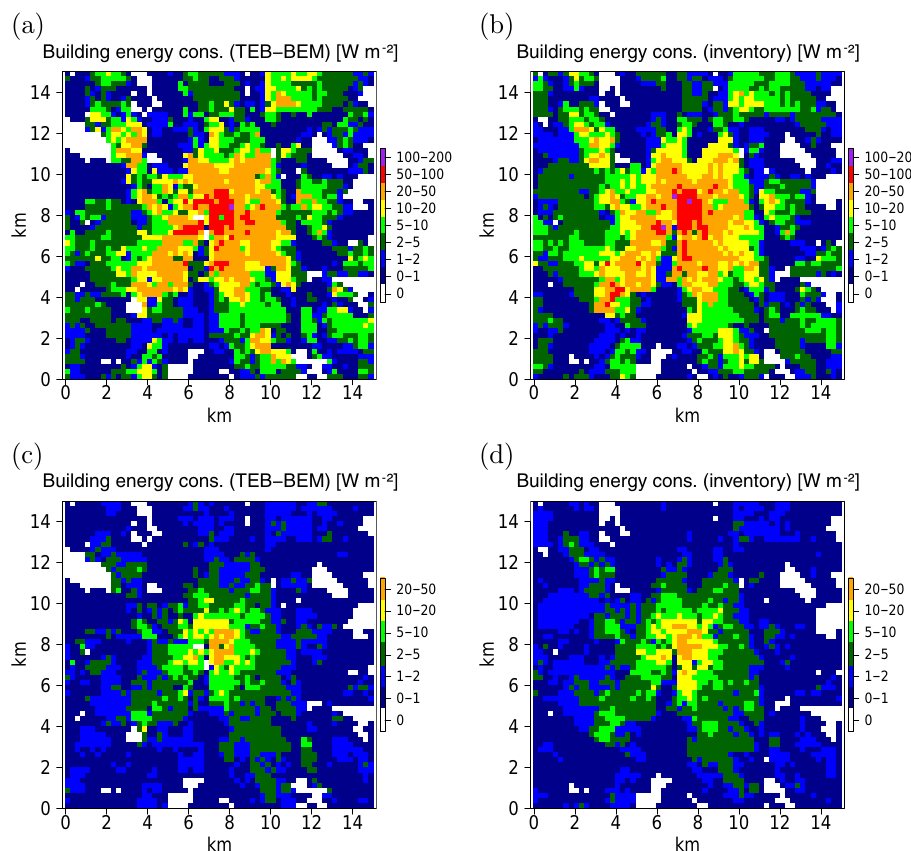
Figure 7. Anthropogenic heat flux due to building energy consumption in the agglomeration of Toulouse simulated for the MAP model configuration. (a) TEB results averaged over December, January and February (DJF); (b) same as (a) , but spatially disaggregated inventory; (c, d) same as (a, b) , but for June, July and August (JJA). The horizontal resolution is 250m ×